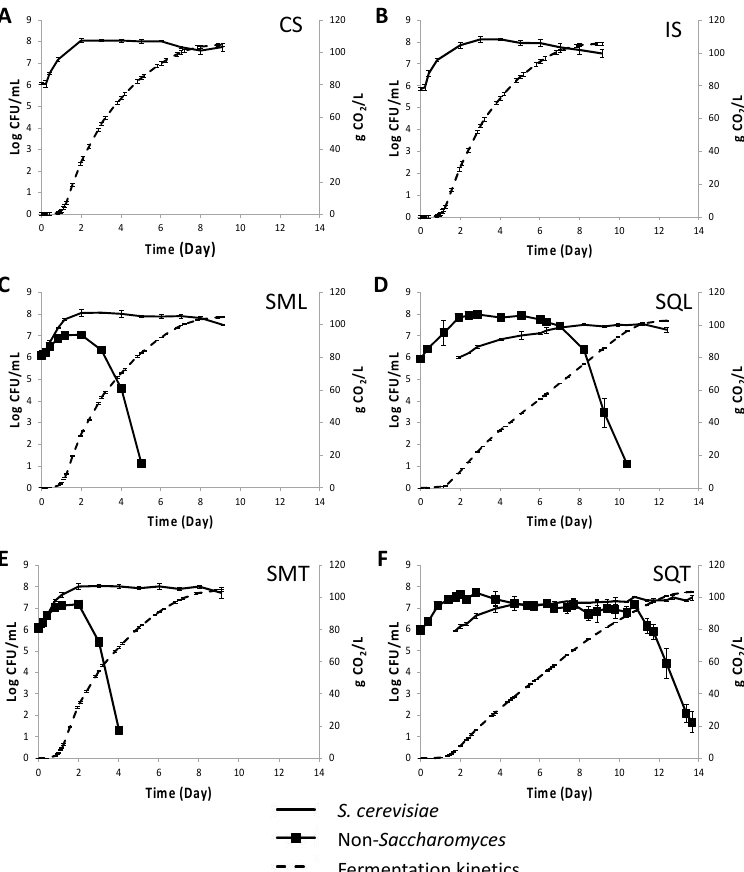
Figure 1. Small-scale laboratory fermentation kinetics (dashed line) and yeast population dynamics (continuous line) in sterile grape must inoculated with ( A ) commercial S. cerevisiae (-), ( B ) S. cerevisiae ScS13 (-), ( C ) L. thermotolerans LtS1 ( ■ ) and S. cerevisiae ScS13 (-) added simultaneously, ( D ) L. thermotolerans LtS1 ( ■ ) and S. cerevisiae ScS13 (-) added sequentially, ( E ) T. delbrueckii TdS6 ( ■ ) and S. cerevisiae ScS13 (-) added simultaneously, and ( F ) T. delbrueckii TdS6 ( ■ ) and S. cerevisiae ScS13 (-) added sequentially.